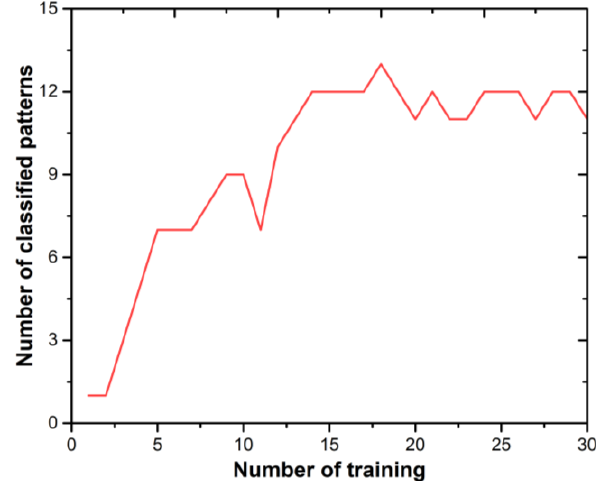
Figure 9. Experimental result of the pattern classification.